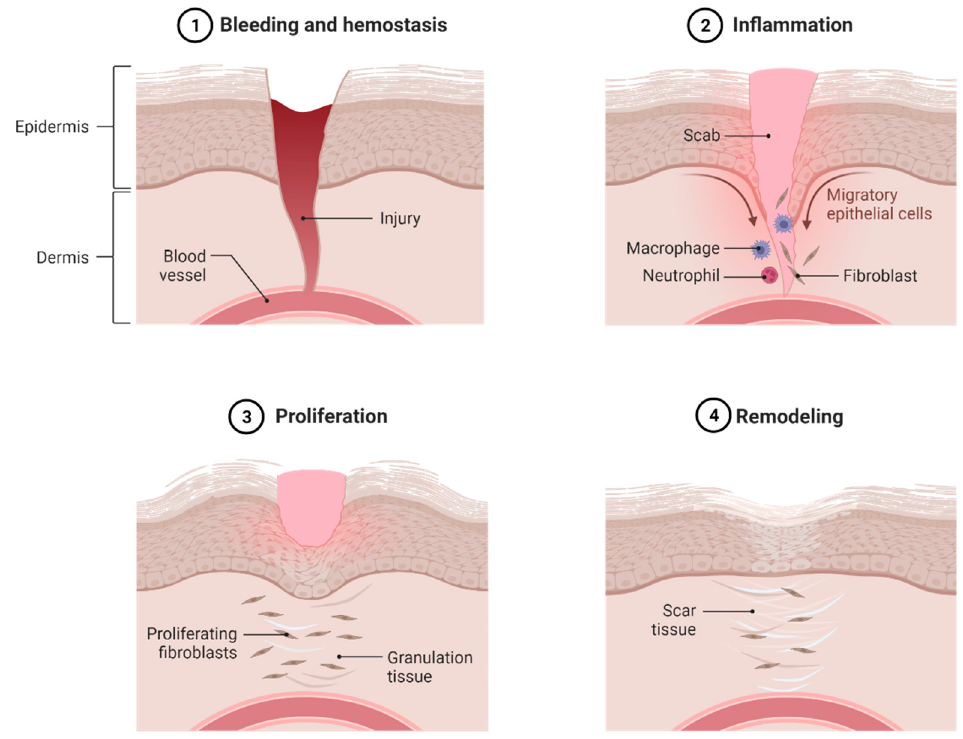
Figure 6. Stages of normal wound healing process. Created with BioRender.com (accessed on 4 February 2023).